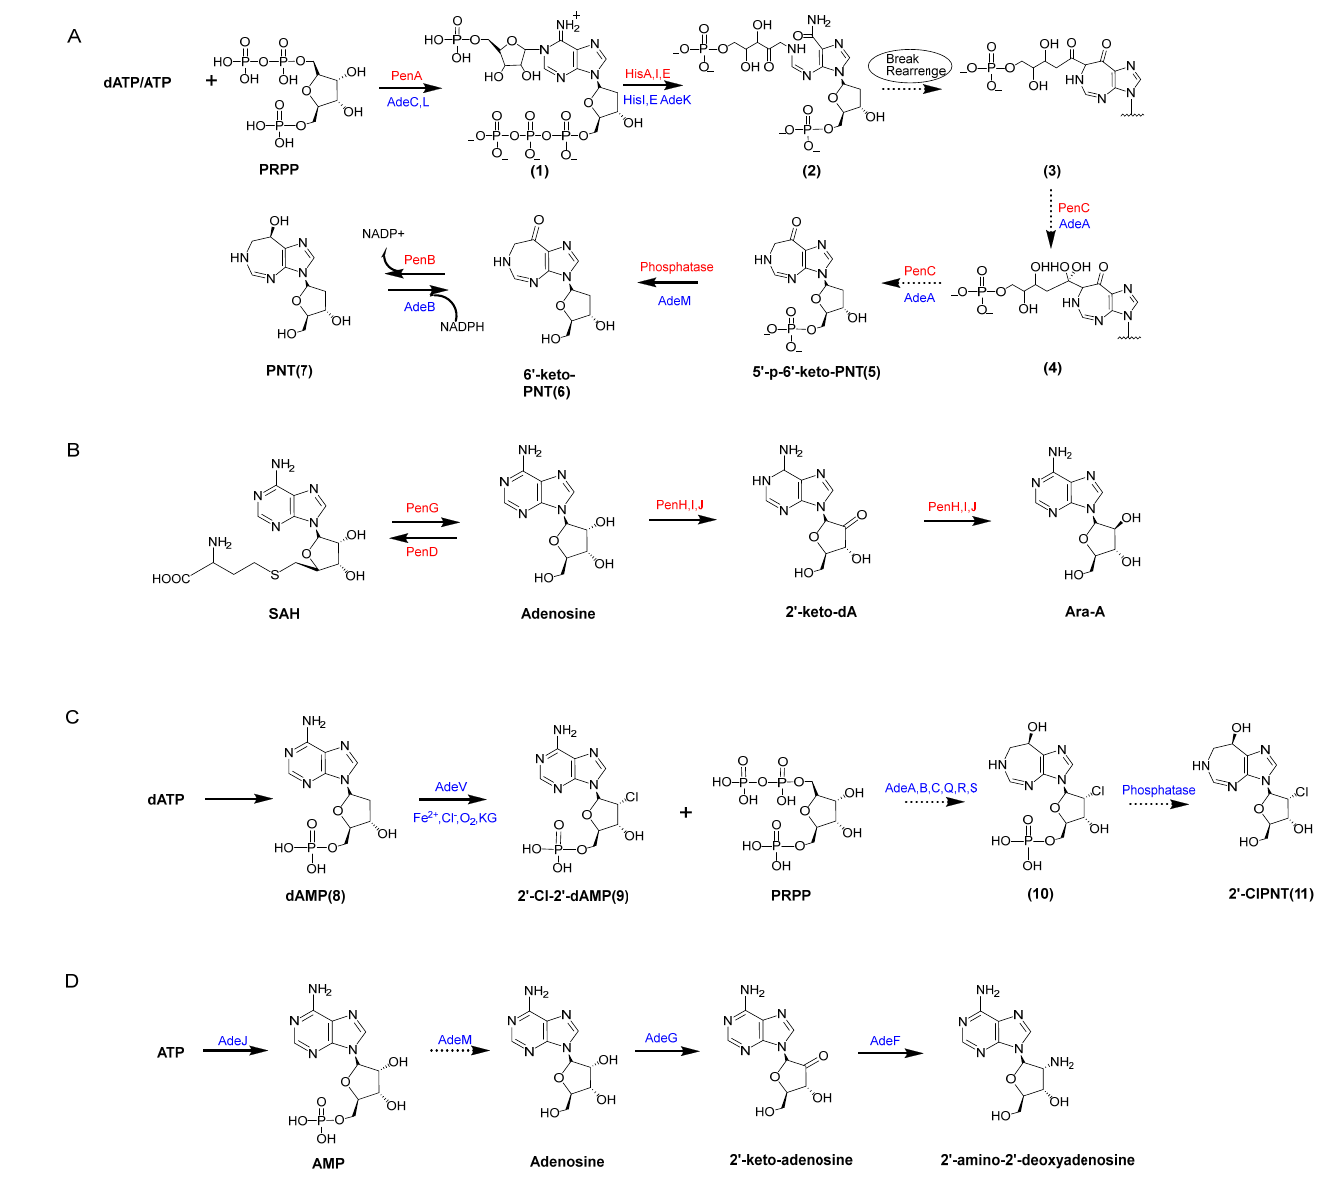
Figure 4. Biosynthesis pathway of PNT and associated products in the Streptomyces antibiotic NRRL 3238 and Actinomadura sp. ATCC39365 (modified from reference [13,14,37]. ( A ): biosynthesis pathway of PNT in the Streptomyces antibiotic NRRL 3238 and Actinomadura sp. ATCC39365. ( B ): biosynthesis pathway of Ara-A in the Streptomyces antibiotic NRRL 3238. ( C ): biosynthesis pathway of 2 ′ - CLPNT in the Actinomadura sp. ATCC39365. ( D ): biosynthesis pathway of 2 ′ - amino -2 ′ -deoxyadenosine in the Actinomadura sp. ATCC39365. The red fonts indicate the biosynthesis pathway in Streptomyces antibiotic NRRL 3238. The blue fonts indicate the biosynthesis pathway in Actinomadura sp. ATCC39365. The dashed arrows indicate that this step is a speculative process. The solid arrows indicate that this step is a determination process.